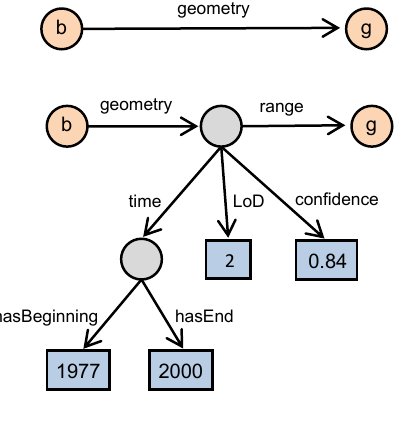
Figure 1. Proposed nD RDF pattern